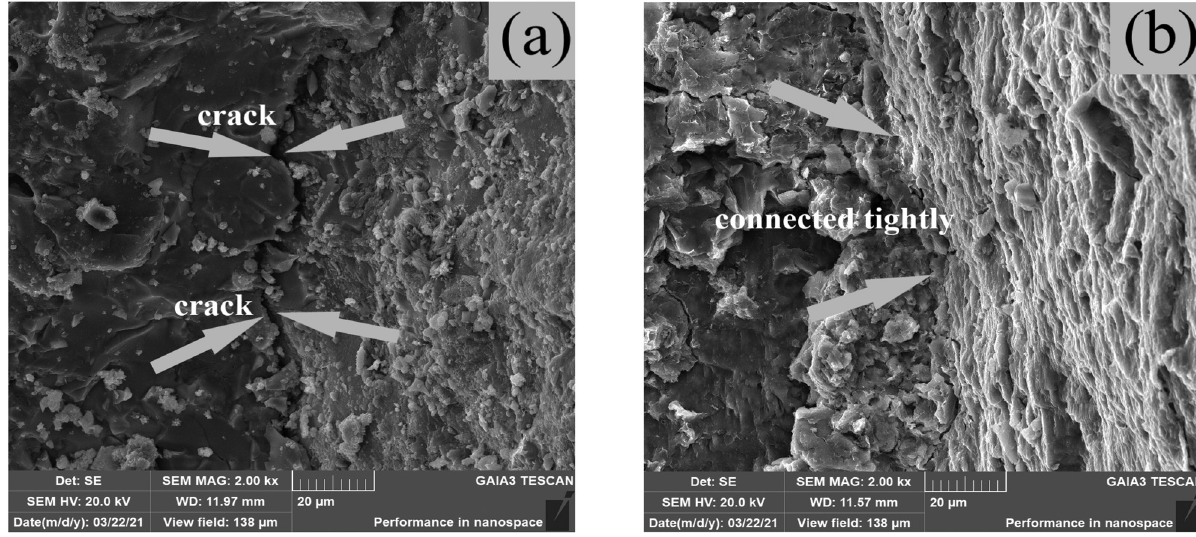
Figure 6: ITZ: ( a ) C and ( b ) SSC 20 – 60